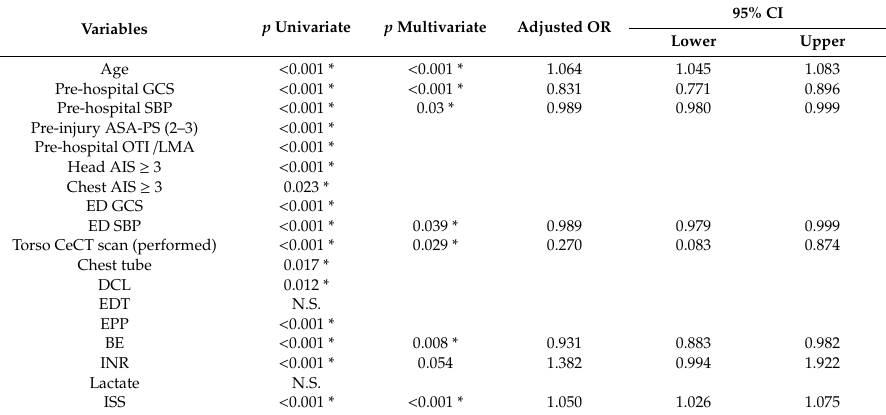
Table 3. Multivariate analysis-independent predictors of